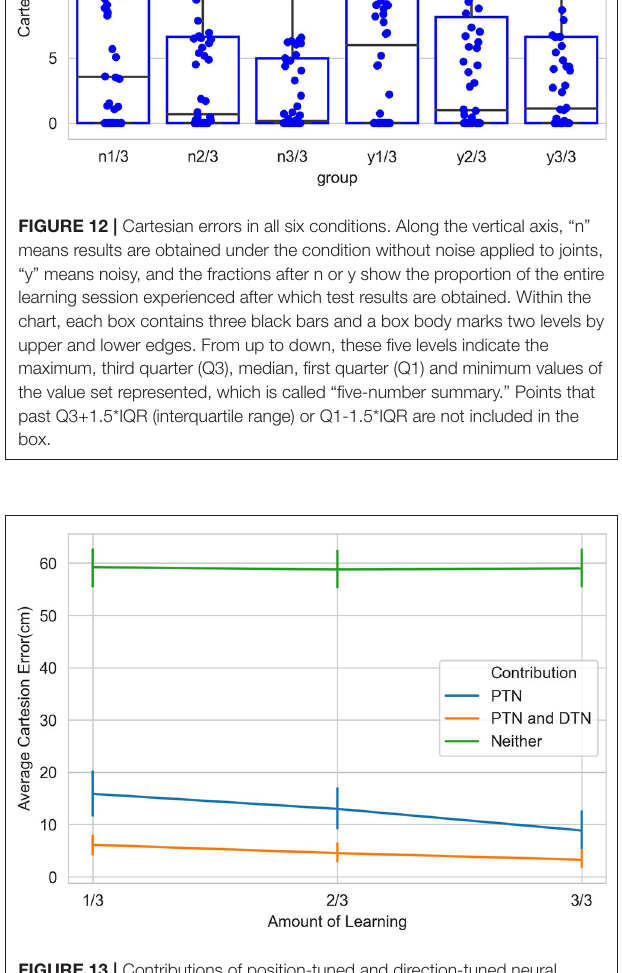
FIGURE 13 | Contributions of position-tuned and direction-tuned neural networks. The three values indicated by the green line are 59.20, 58.80, and 59.00 cm, respectively from 1 to 3 of the learning session to the end of the full session. With PTN involved, as shown by the blue line, these three values are 15.89, 13.00, and 8.86 cm. When both PTN and DTN are functioned, these three values are reduced to 6.74, 4.55, and 3.28